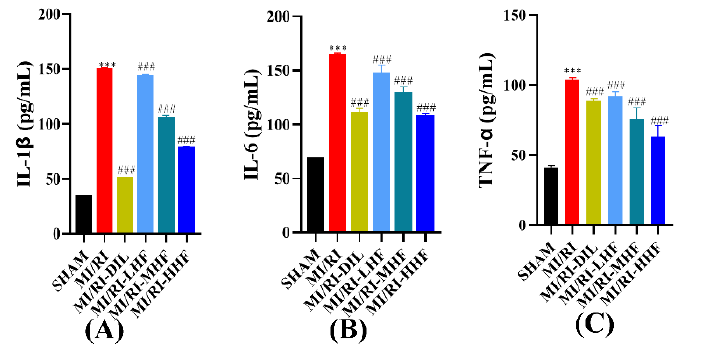
Figure 5. Effects of HF on inflammatory cytokines. ( A ) IL-1 β ( n = 15~16). ( B ) IL-6 ( n = 15~16). ( C ) TNF- α ( n = 15~16). Results were expressed as mean ± SD. *** p < 0.001 vs. SHAM group. ### p < 0.001 vs. MI/RI group.